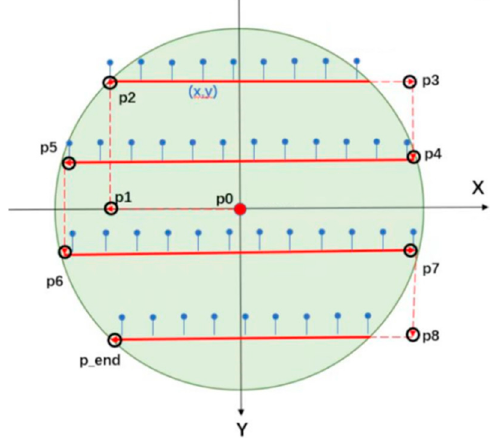
Figure 6. Scanning path generation algorithm.